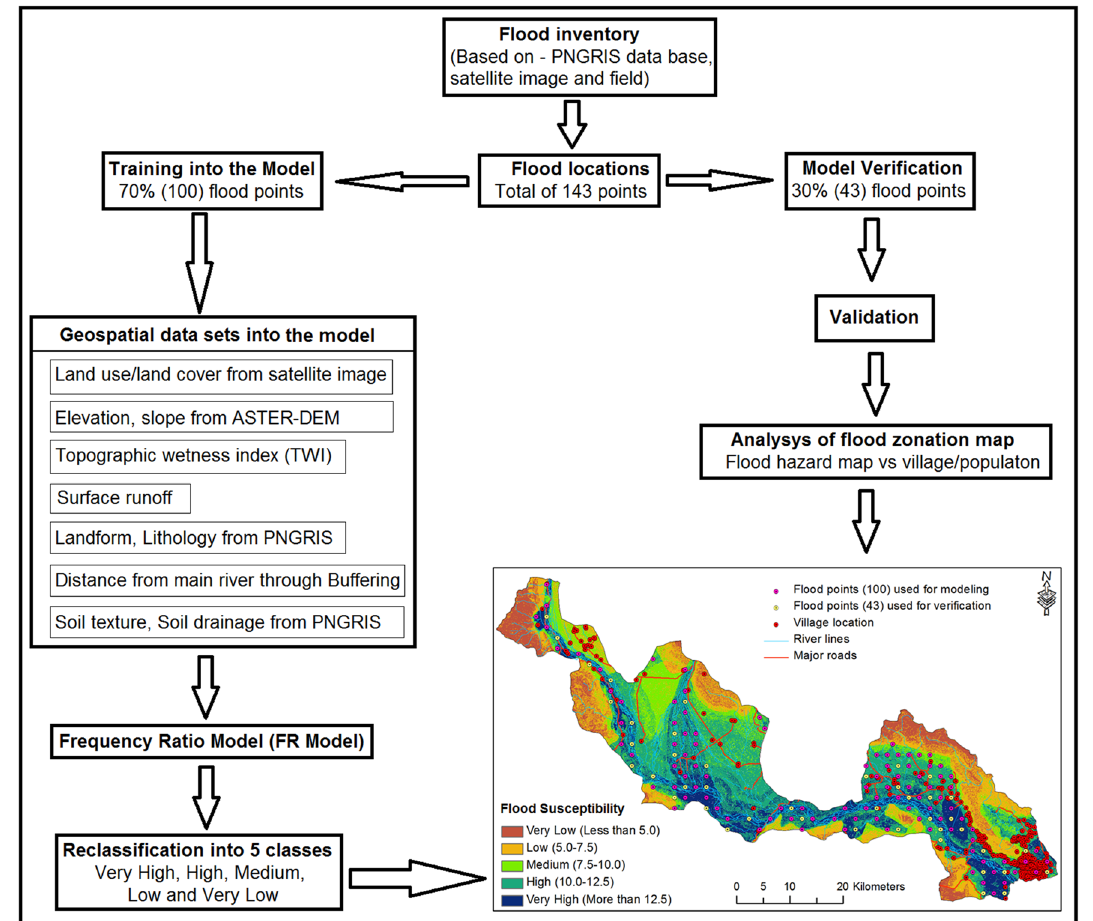
Fig. 3 Methodological flow chart of flood susceptibility